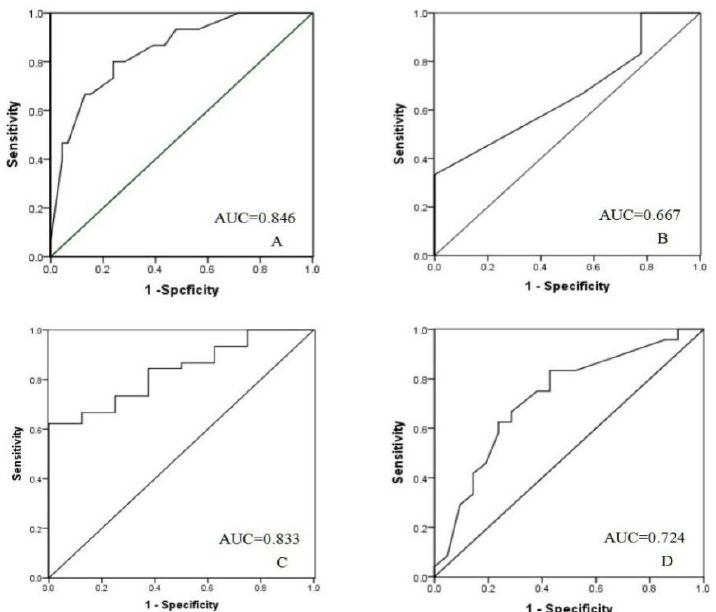
Figure 2. Receiver operating characteristic (ROC) curve of the QS duration in aVL ( A ), the R duration in II ( B ), the ratio of III/II ( C ) and the QS duration in aVR ( D ) to distinguish LVOT VAs. According to the accuracy of AUC, a stepwise ECG algorithm was developed (Figure 3). First, QS duration in aVL > 134 ms was used to distinguish VAs from AMC, LV summit and VAs from aortic root. Second, R duration in II > 155 ms was used to differentiate VAs from LV summit and VAs from AMC. Third, the ratio of III/II < 0.9 was used to discriminate VAs from RCC and VAs from LCC, L-RCC. Fourth, the QS duration of aVR > 130 ms was used to discern VAs from LCC and VAs from L-RCC.